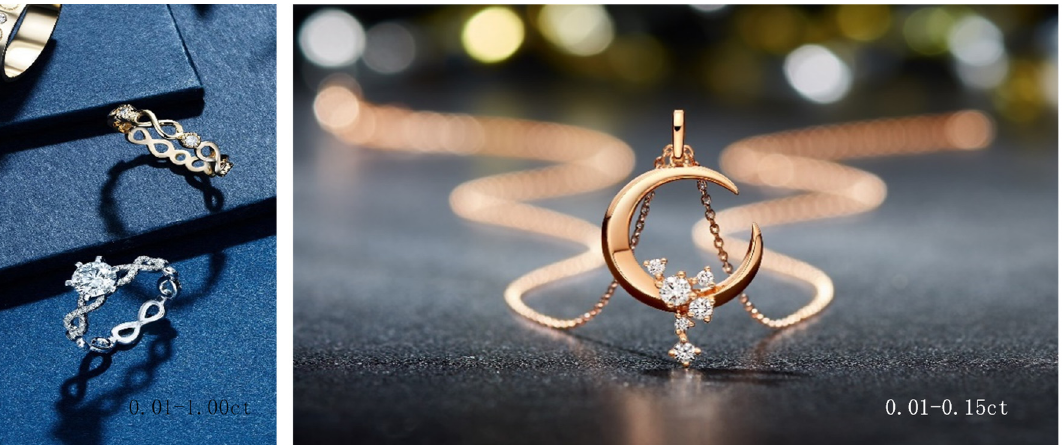
Figure 1. Jewelry made from Chinese HPHT synthetic diamonds (weights ranging from 0.01 to 5.00 ct), 2019. Images courtesy of two companies (Zhengzhou Sino-Crystal Diamond Co., Ltd. Shenzhen